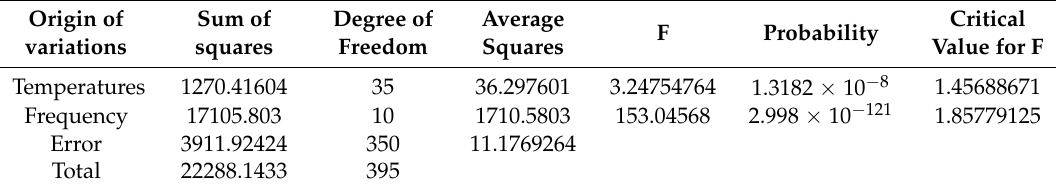
Table 20. ANOVA for